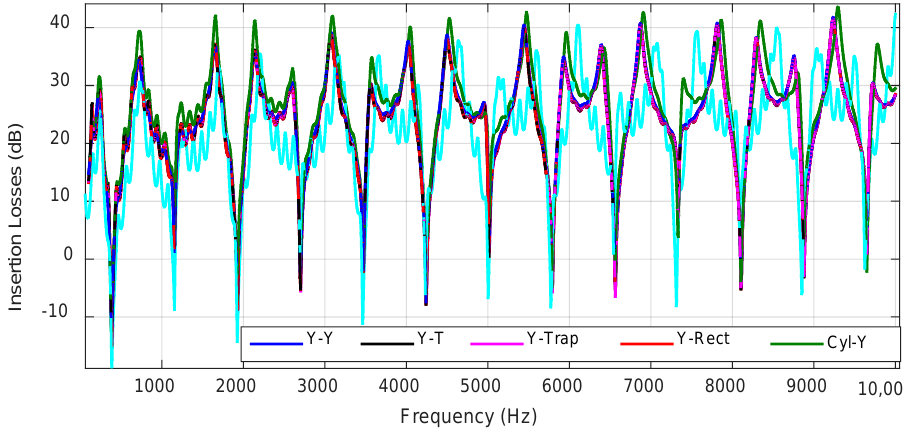
Figure 17. IL in Configuration 2 (‘Car–Balcony’) using double caps formed with Y-shaped structures and a single screen barrier as a reference.